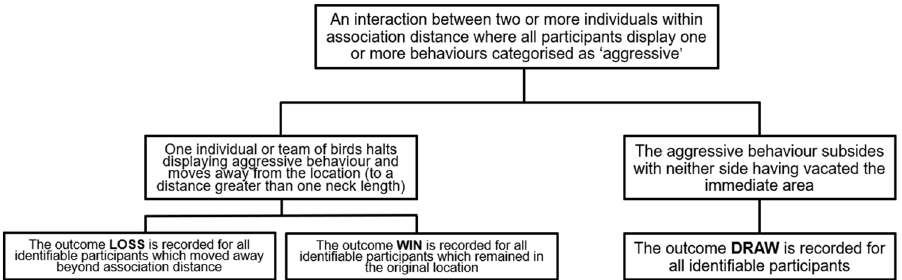
Figure 3. Criteria for the recording of fight outcome in the collection of social support